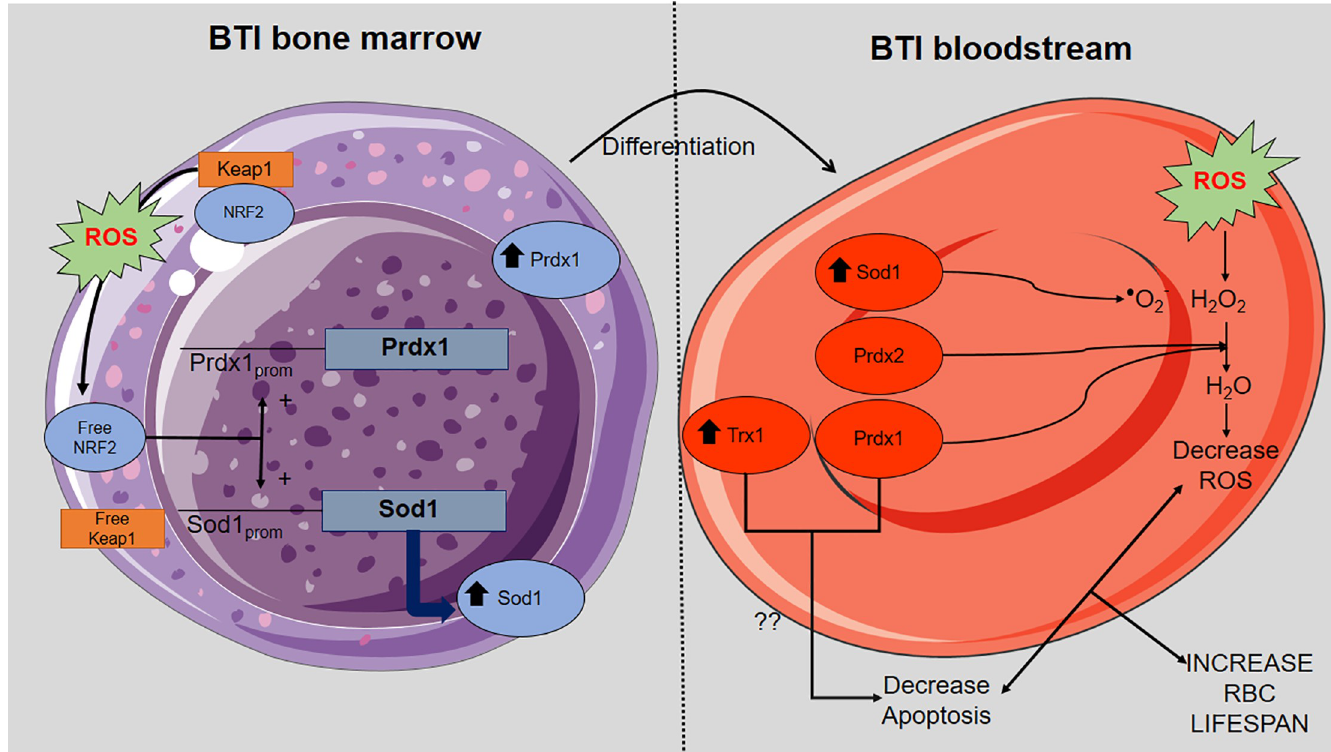
Fig 8. Model of interaction between Prdx1 and Prdx2 in the detoxification of hydroperoxides of BTI RBCs. An increase in ROS production during the development of RBCs results in Keap1 oxidation and consequent liberation of free Nrf2, contributing to the upregulation of Prdx1 and Sod1. In the bloodstream the upregulation of Prdx1 can act together with Sod1 and Prdx2 in the detoxification of ROS. In addition, Prdx1 associated with Trx1 leads to decrease in apoptosis. Altogether, these processes contribute to increase BTI RBCs lifespan.